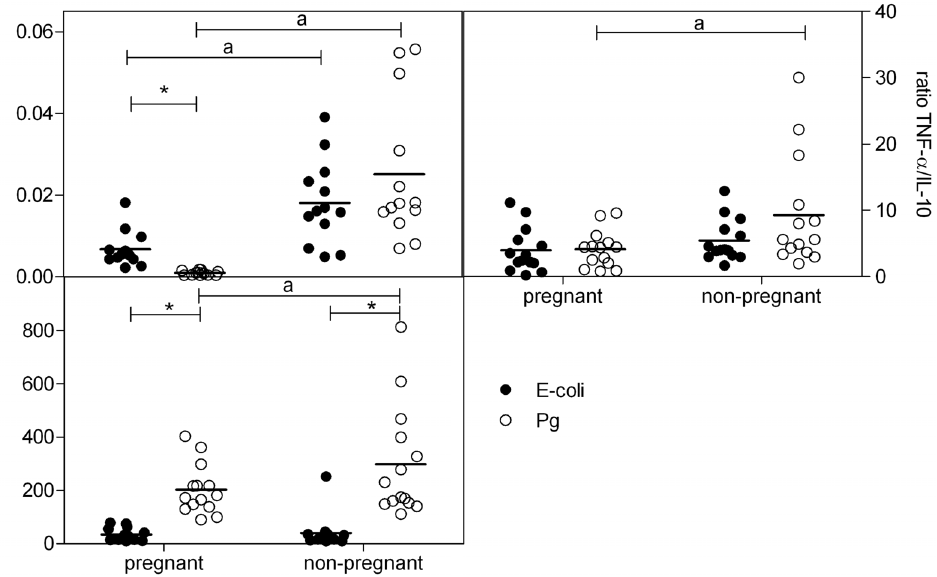
Figure 5. Pro-inflammatory/anti-inflammatory cytokine ratio following stimulation with LPS. Ratio of IL-12/IL-10, TNF a /IL-10 and IL-6/IL- 10 cytokine production in plasma of pregnant and non-pregnant women following stimulation of whole blood with E-coli (black dots) or P. Gingivalis (PG) (open dots) LPS (2 m g/ml) for 24 hr. *significantly different from E-coli (two-way ANOVA followed by Bonferroni post-tests, p , 0.05). a: significantly different from pregnant women after the same stimulation (two-way ANOVA followed by Bonferroni post-tests, p , 0.05).